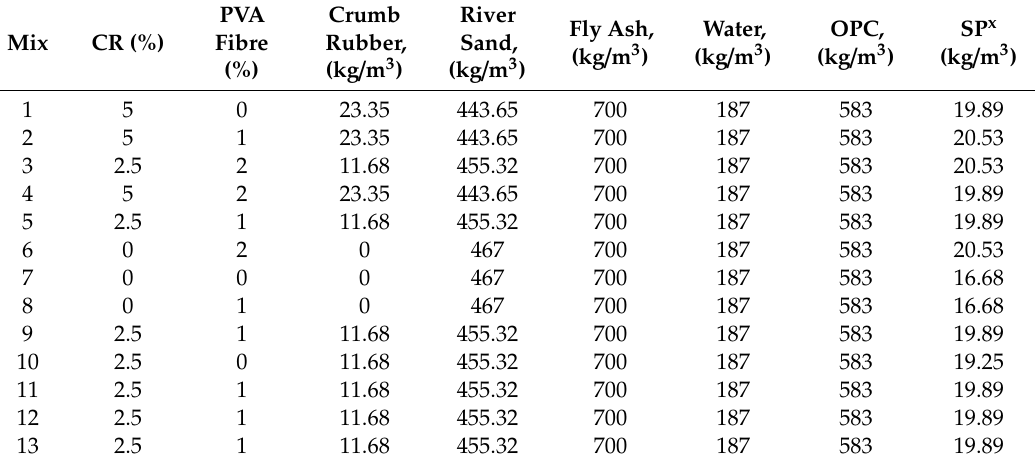
Table 3. Mixture proportion of